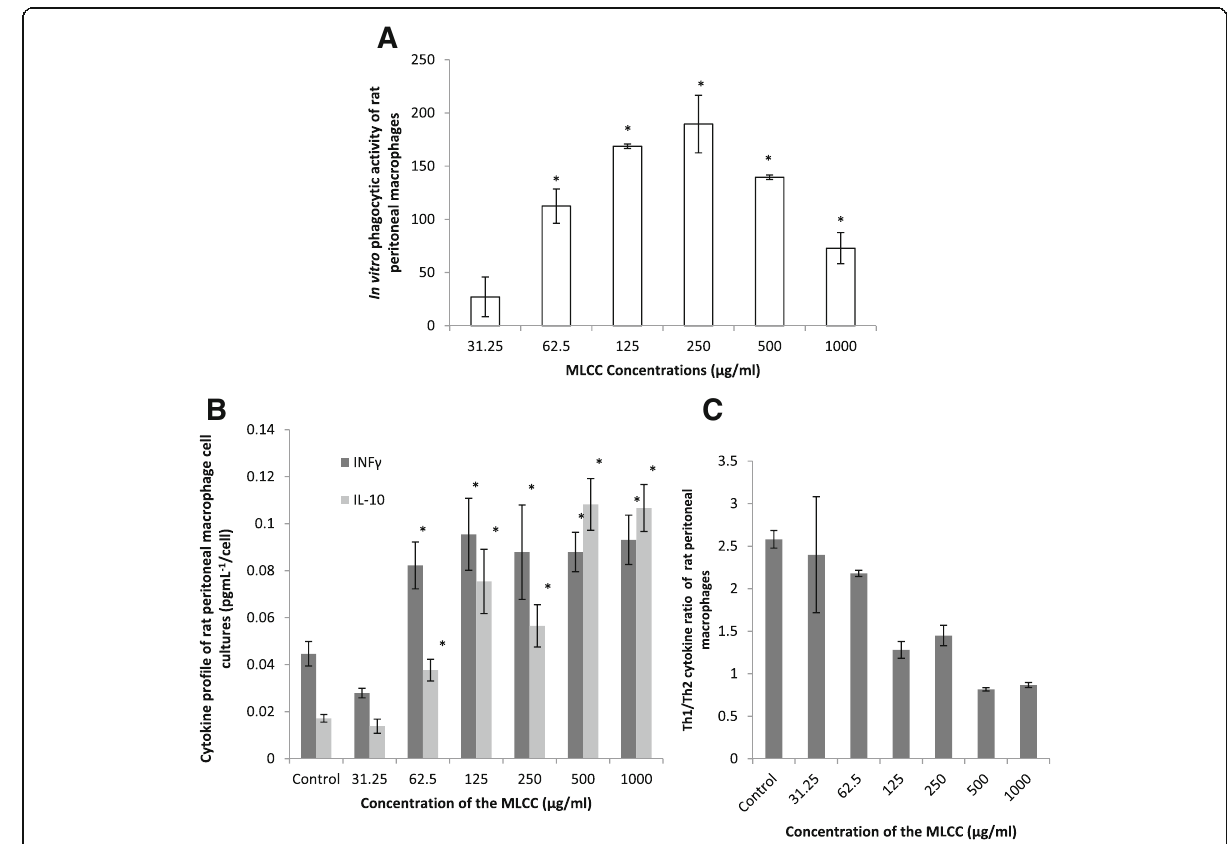
Fig. 4 Effect of the MLCC on a in vitro phagocytic activity of rat peritoneal macrophages, b the associated cytokine; IFN γ and IL-10 profile. c Th1/Th2 bias cytokine response. Results are expressed as Mean ± SEM. * p < 0.05, ** p < 0.01 were considered significant when compared with the control